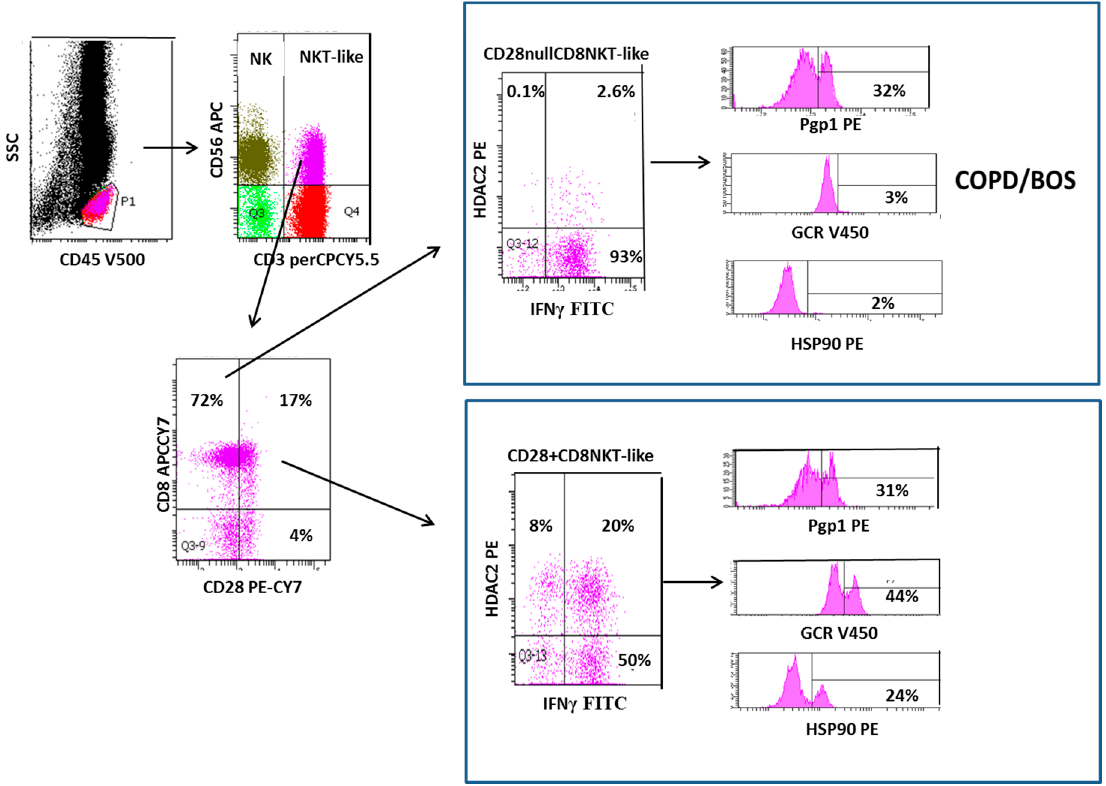
Figure 1. Flow cytometric gating technique used to identify cluster of differentiation (CD)28nullCD8+natural killer T cell like (NKT-like) cells. Identification of lymphocytes as CD45+ low side scatter (SSC) events; Identification of NKT-like cells as CD3+CD56+ events; Identification of CD8+ NKT-like cells using CD8 APC-CY7 staining; Identification of CD28nullCD8+NKT-like cells using CD28 PE-CY7 staining; expression of interferon gamma (IFN γ ) and histone deacetylase 2 (HDAC2) in CD28nullCD8+NKT-like cells and CD28+CD8+NKT-like cells; Expression of P-glycoprotein 1